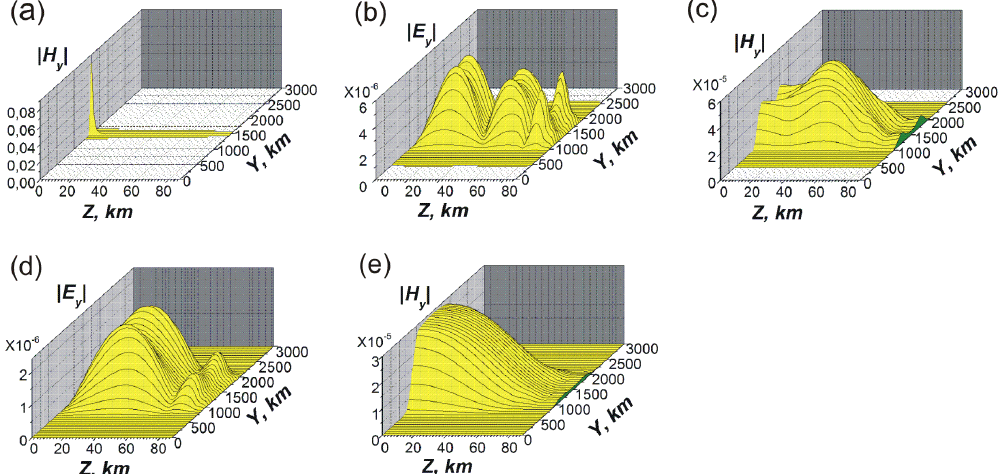
Figure 4. Panel (a) is the initial distribution of | H y | at x = 0. Panels (b) and (c) are | E y | and | H y | at x = 600km. Panels (d) and (e) are | E y | and | H y | at x = 1000km. For the electric field, the maximum value (d) is 3 × 10 − 6 Gs ≈ 1mVcm − 1 ; for the magnetic field, the maximum value (e) is 3 × 10 − 5 Gs ≈ 3nT. At the altitudes z < 75km , | E z | ≈ | H y | . ω = 1 . 0 × 10 5 s − 1 and θ = 45 ◦ .